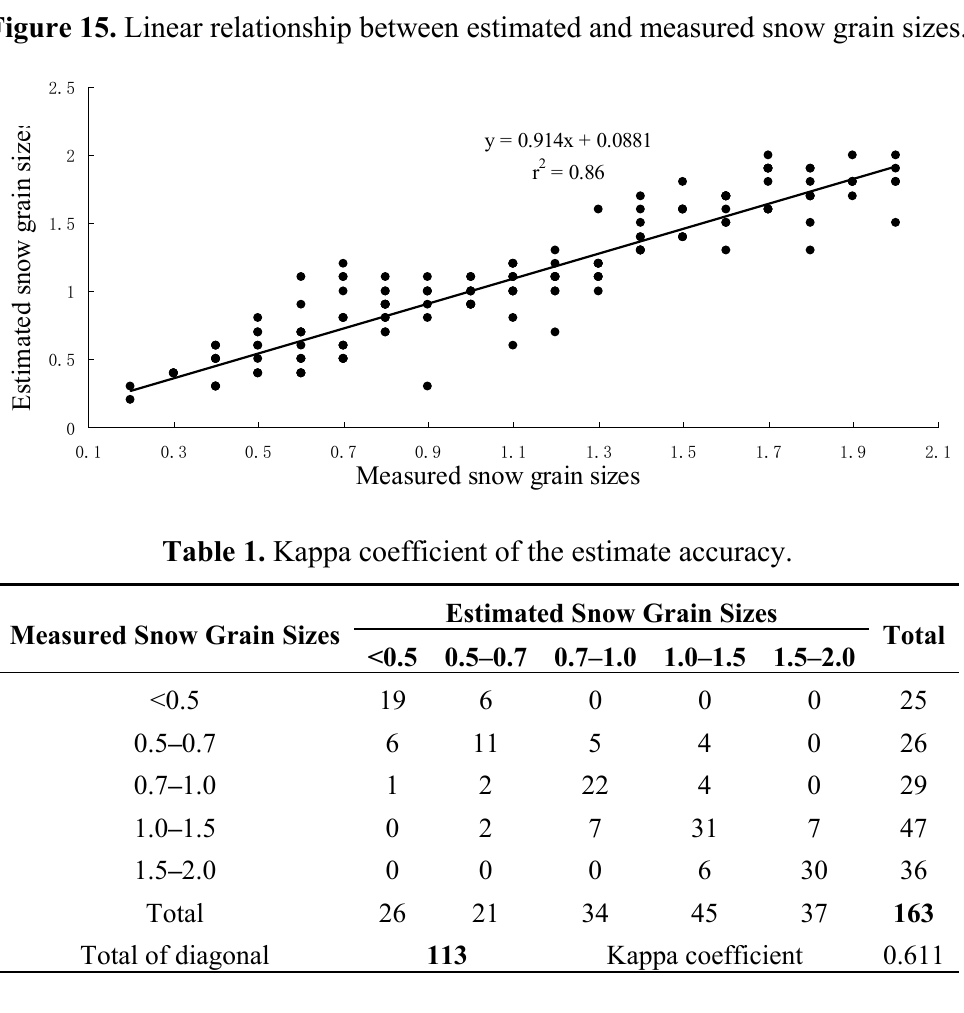
Figure 15. The linear relationship coefficient r 2 is 0.86. The kappa coefficient of the estimate accuracy was calculated (Table 1). Figure 15. Linear relationship between estimated and measured snow grain sizes.